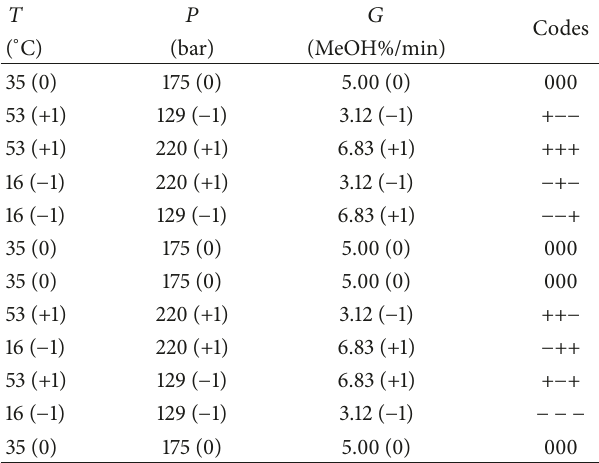
Table 1: Design of Experiment (DoE) based on Brereton’s